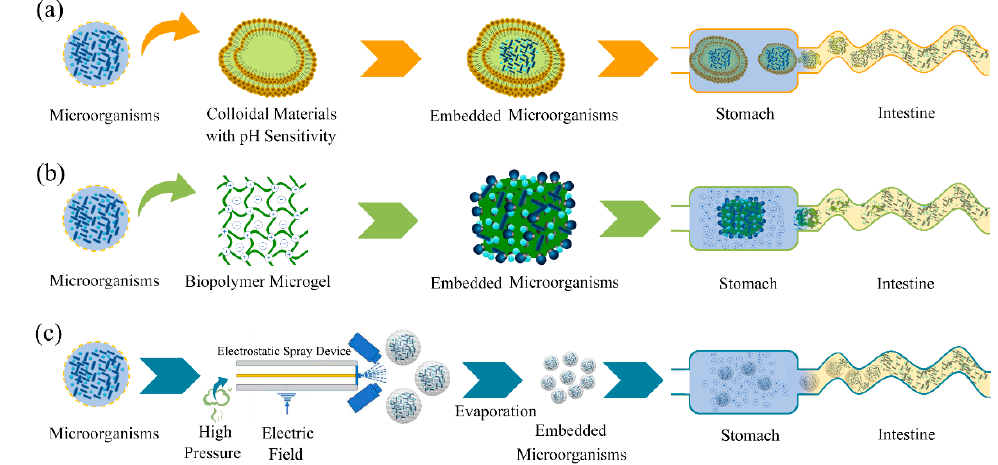
Figure 4. The protection principle of different embedding methods for microorganisms. ( a ) Microspheres/microcapsules mainly used colloidal materials with pH sensitivity to achieve multilayer embedding of microorganisms, and microcapsules disintegrated layer by layer to help microorganisms targeting release at the specific site in intestine. ( b ) Biopolymer microgels mainly protected microorganisms by adding colloidal antacids. Colloidal antacids maintained a neutral internal pH of biopolymer microgels under stomach conditions due to the ability of the hydroxyl ions for colloidal antacids to neutralize hydrogen ions arising from the gastric fluids. ( c ) Electrospraying made the emulsion dispersed into uniform and stable micron or nanometer droplets by high pressure and applied electric field .